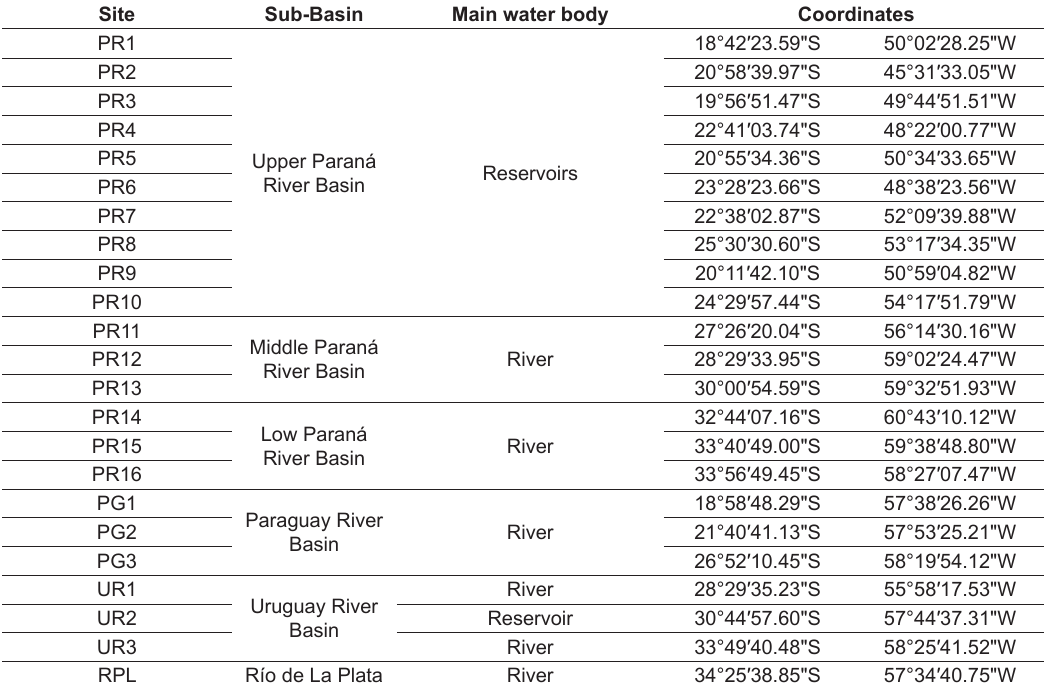
Table 1. Sampling sites codes, kind of the associated main water body, hydrographic sub-basin and geographical coordinates.